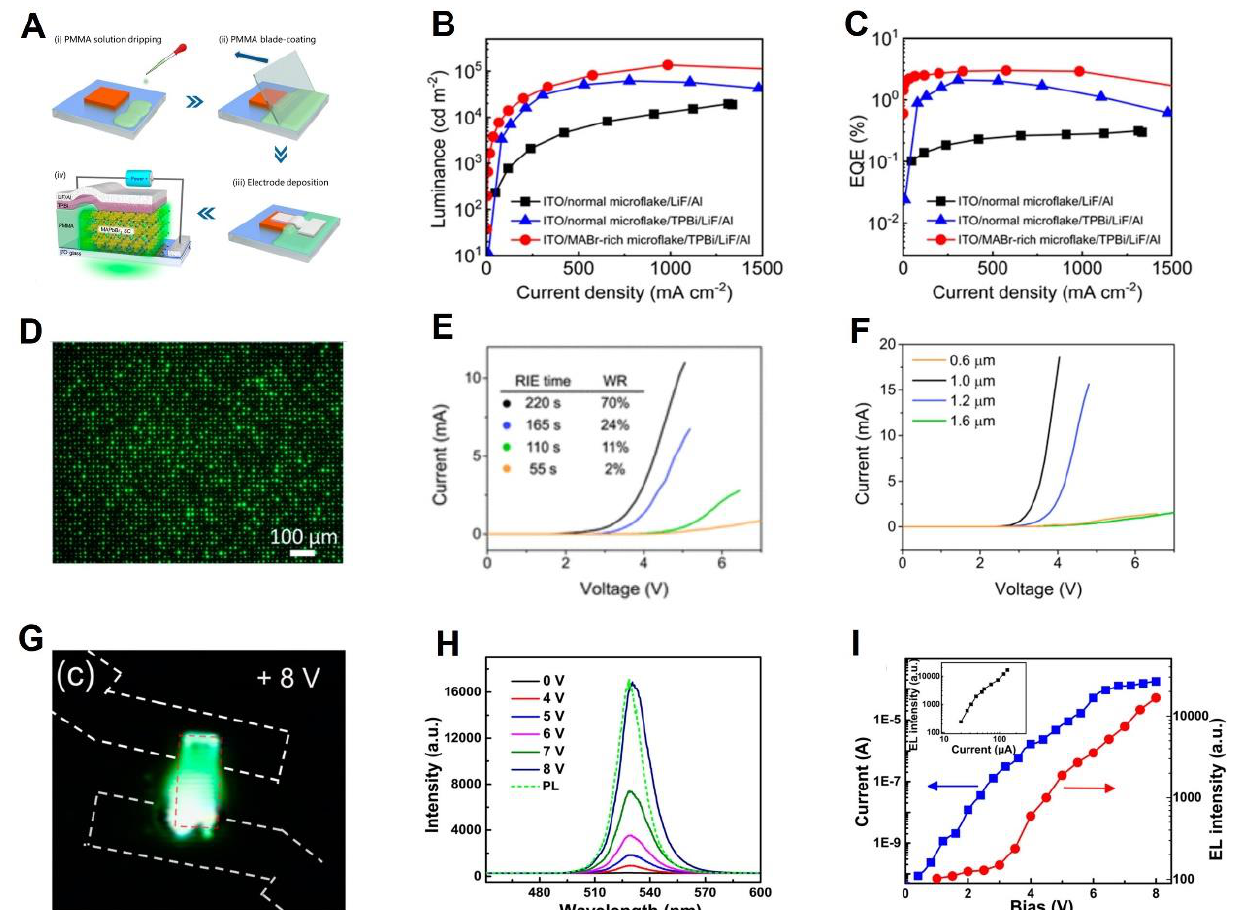
Figure 4. ( A ) The flow of building the device through the LIB method. ( B ) The luminance and ( C ) EQE of the device under different perovskite precursor concentration ratios and structures [44]. Copyright 2022, ACS Publications. ( D ) Surface image of the single − crystal LED after the voltage exceeds the threshold. ( E ) I – V curves of the device at different reactive ion etching times. ( F ) The I – V curves of the devices at different single crystal array thicknesses [48]. Copyright 2020, ACS Pub- lications. ( G ) Color image of an electroluminescence device at a bias of 8 V. ( H ) The EL spectrum at different biases of the device (the PL spectrum is described by a dashed line). ( I ) Plot of EL intensity and current trend at an increased voltage [49]. Copyright 2017, ACS Publications.